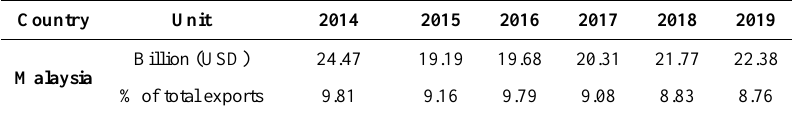
Table 2. International Tourist Receipts for Malaysia,